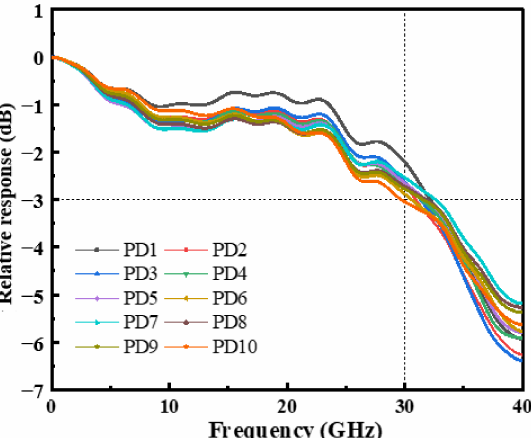
Figure 6. Frequency response measurement result of the photodetector (PD) array at 5 V reverse